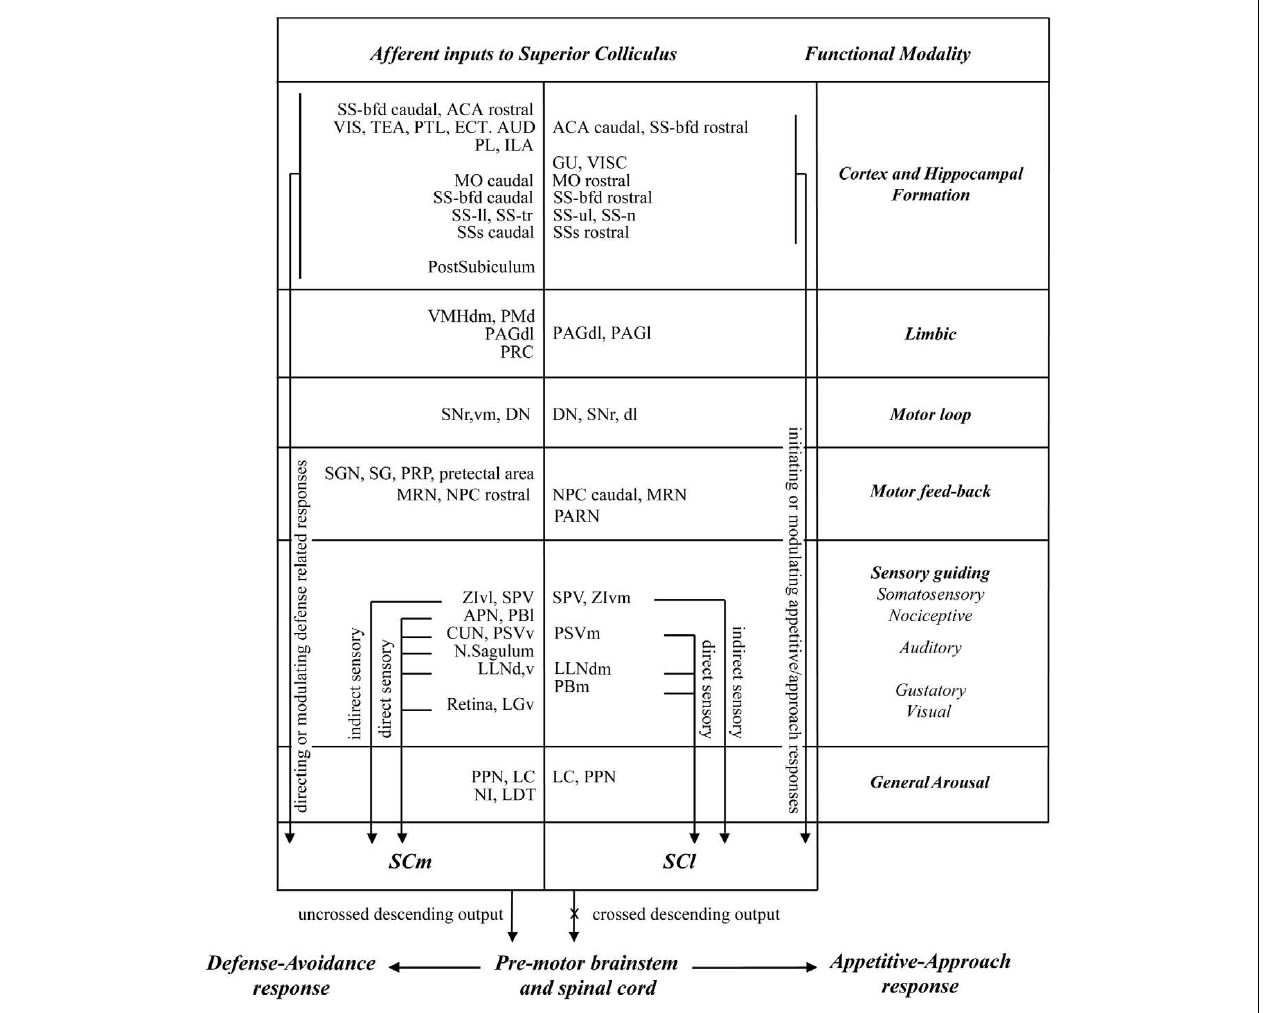
FIGURE 9 | Summary of the functional inputs to sub-regions of the rat SC associated with approach and defense responses.